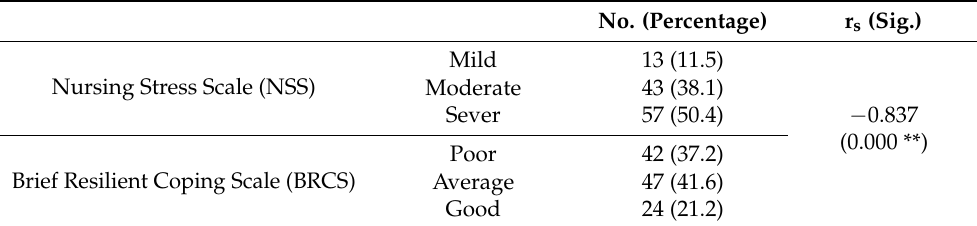
Table 2. Total Score of Nursing Stress Scale and Brief Resilience Coping Scale among Studied Nurses. ( n =